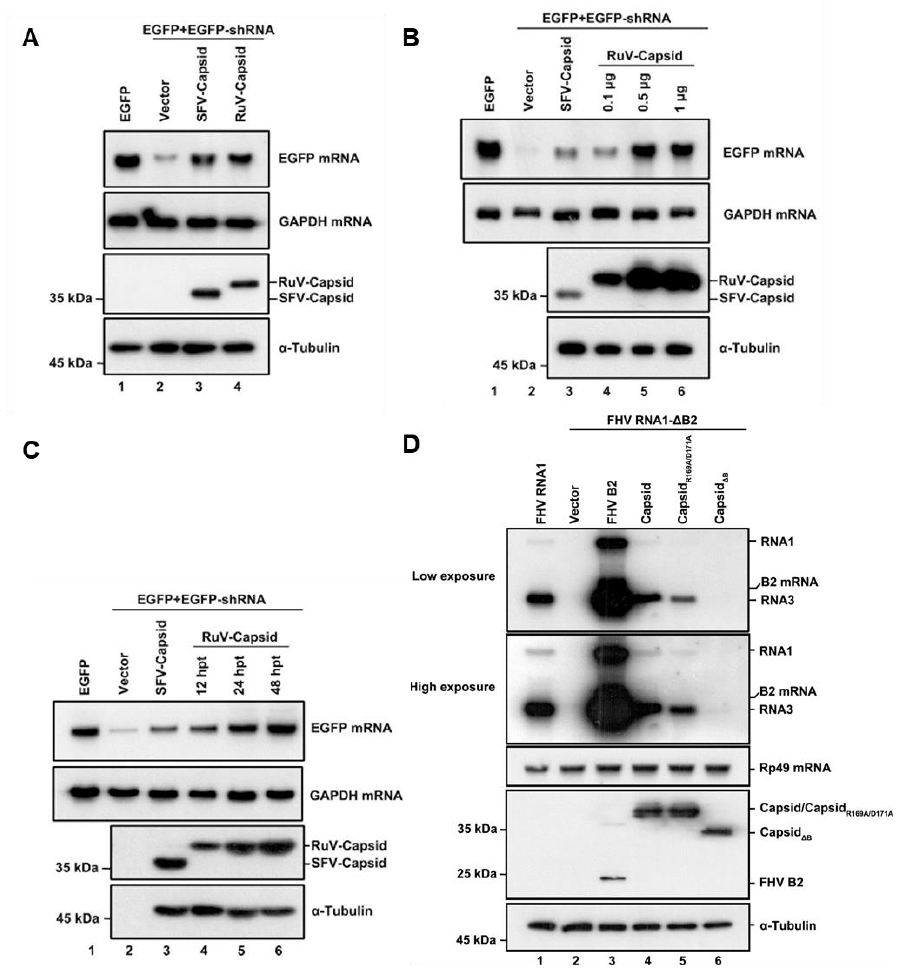
Figure 1. RuV capsid is a potent VSR in mammalian cells. ( A ) HEK293T cells were co-transfected with plasmids encoding EGFP (100 ng), EGFP-specific shRNA (shEGFP) (300 ng), and RuV capsid (1 μg), respectively. Cellular lysate and total RNAs were harvested and analyzed by Western and Northern blotting, respectively. Empty vector (Vec) and SFV capsid were used as a mock control and positive control, respectively. ( B ) Increasing amounts of RuV capsid-encoding plasmid were transfected into HEK293T cells in the reversal-of-silencing assay. At 48 h post transfection (hpt), Northern blotting was performed to determine the EGFP mRNA levels. ( C ) Northern blotting was performed 12, 24, and 48 hpt. ( D ) S2 cells were transfected with pMT-FHV RNA1 (FHV RNA1) (30 ng) or pMT-FHV-ΔB2 RNA1 (FR1 ΔB2) (600 ng), together with a plasmid encoding RuV capsid or FB2 (1 μg for each), as indicated. At 24 hpt, FHV RNA transcription was induced by incubation with CuSO 4 (0.5 mM). At 24 h after induction, the total RNAs were harvested for Northern blot analysis. All the experiments have been independently repeated at least three times with reproducible results, and the representative results are shown.